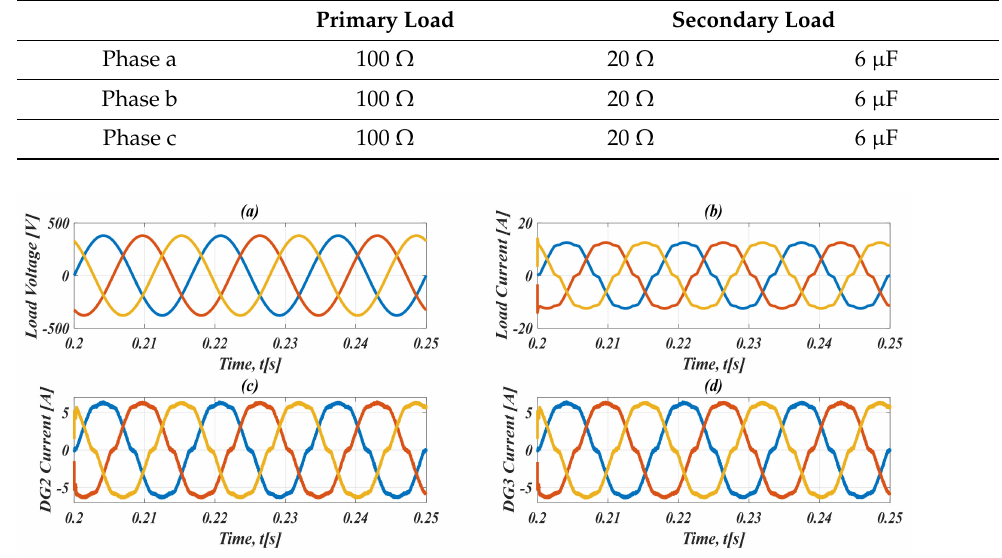
Figure 7. Load and Current Waves in Transient Operation Under Non-linear Load: ( a ) Load Voltage, ( b ) Load current, ( c ) DG2 Current, ( d ) DG3